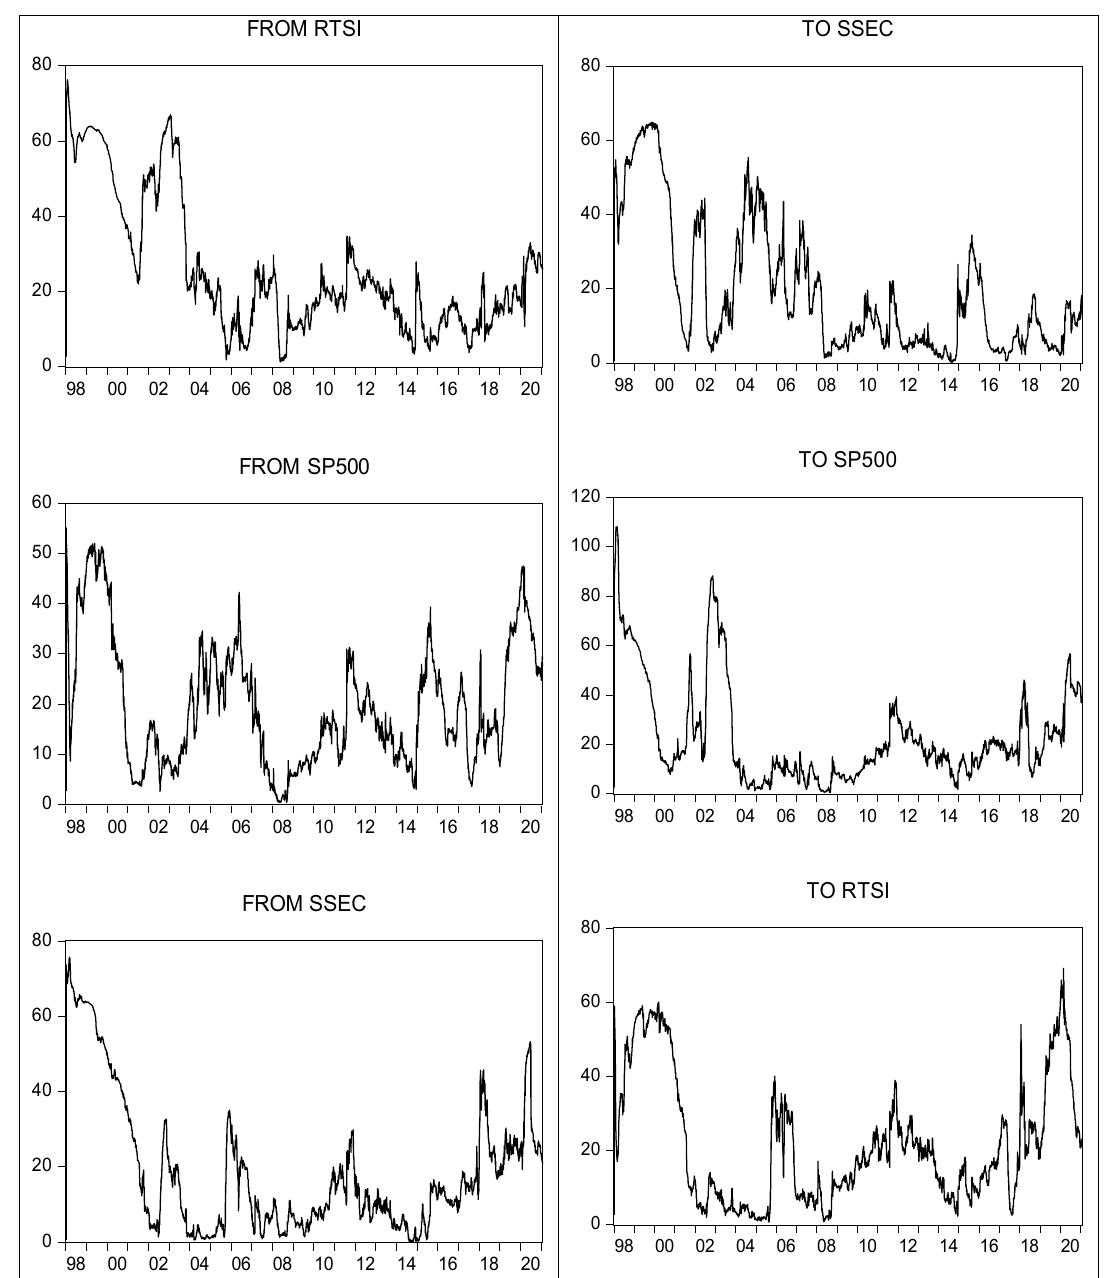
Figure 1. Volatility spillover from and to the three stock markets.